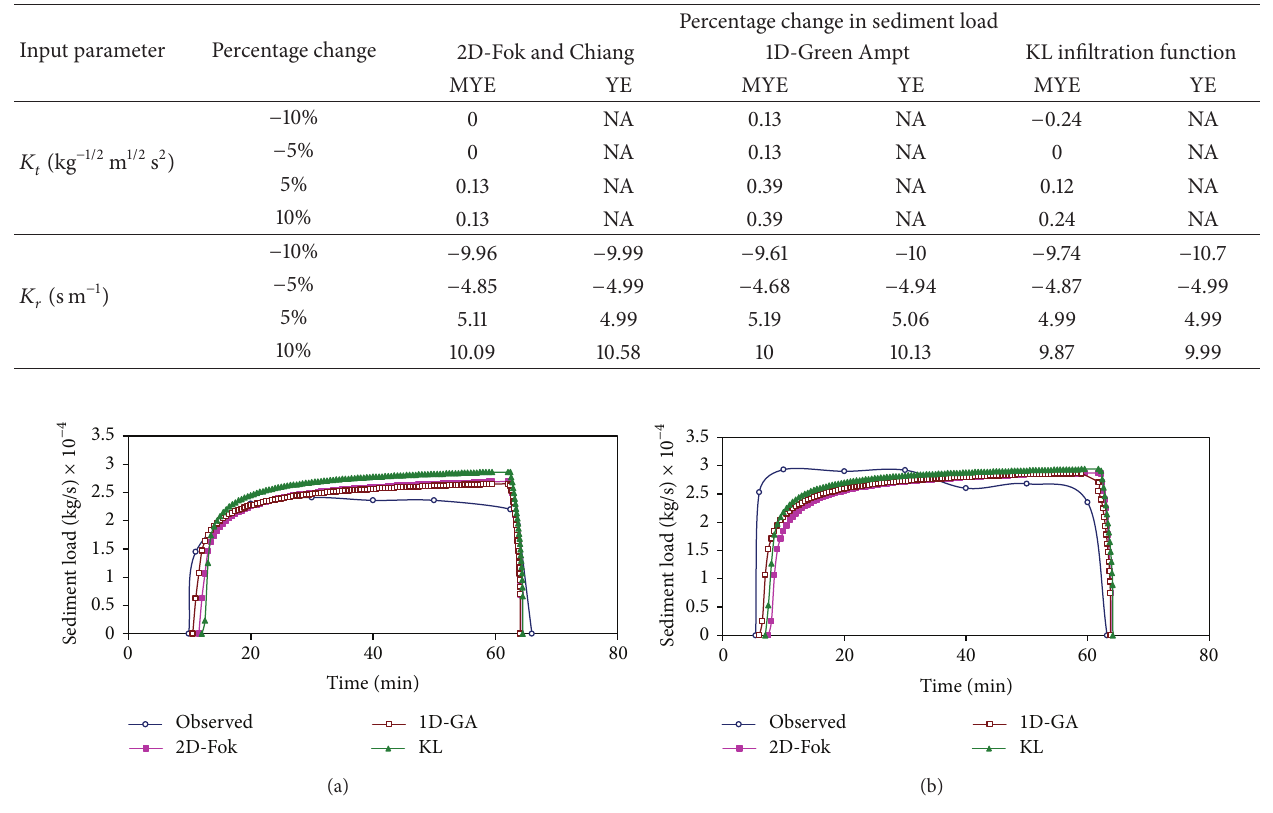
Figure 4: Comparison of observed and simulated sediment load (using YE) for (a) 16th May 2005 and (b) 30th March 2005 irrigation events.